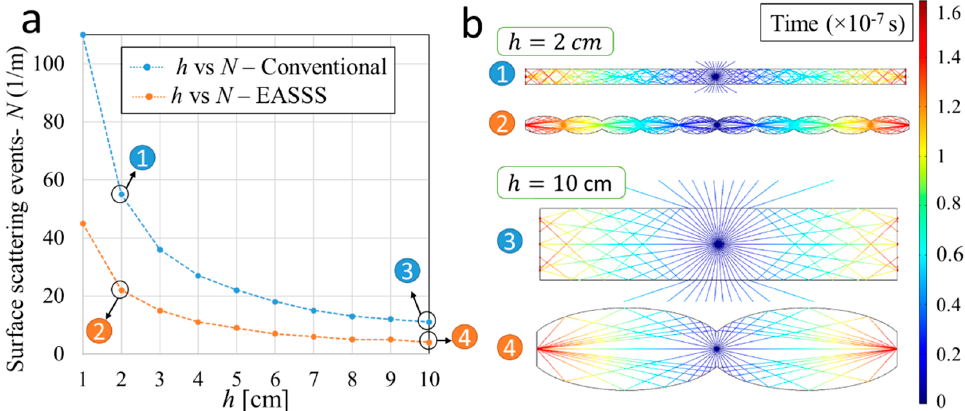
Figure 5. ( a ) A comparison of surface scattering loss events on a per-meter basis for light propagating along the planar direction (the x -direction) of an EASSS and a conventional flat-panel LSC for a constant value of c / a = 0.91; and ( b ) The trajectory of light emitted from the center of a conventional LSC panel and EASSS for two cases wherein the height of the panels is h = 2 and h = 10 cm.